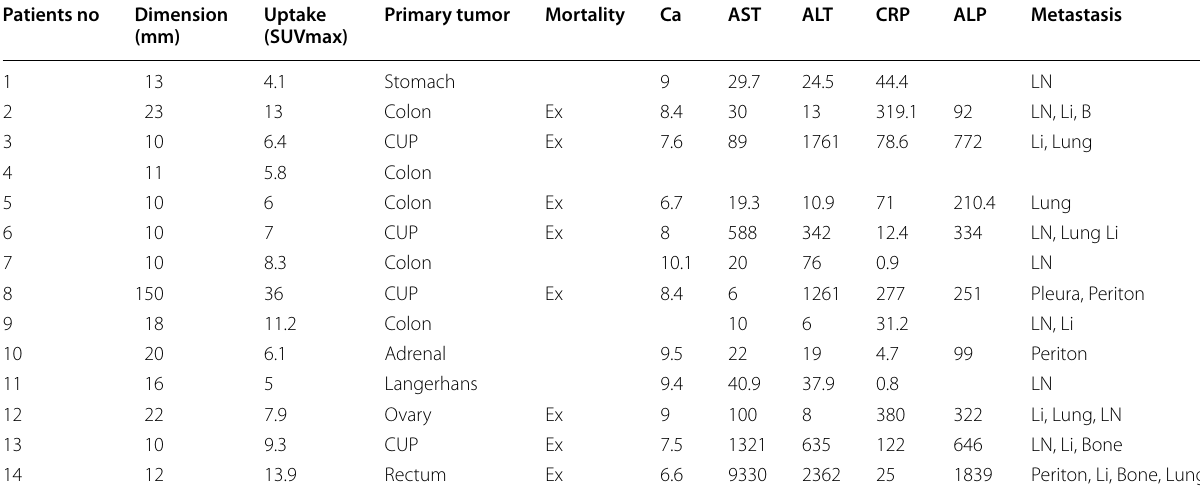
CUP: Carcinoma of unknown primary, SUVmax: standardized uptake value, Ca: calcium, CRP: C-reactive protein, ALP: alcalenephosphatase, LN: lymph node, Li: liver